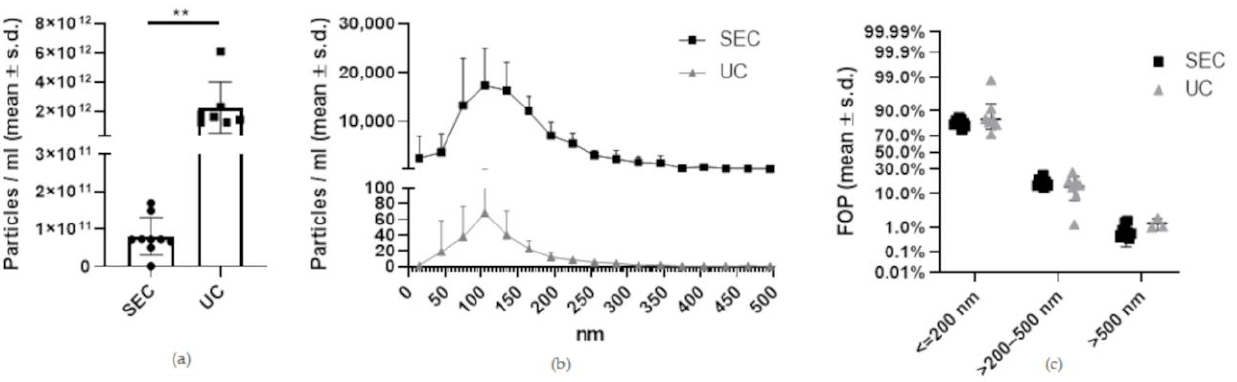
Figure 3. Particle number and size distribution of equine MSC-EVs based on NTA measurements. ( a ) Significantly more particles per ml were found in the UC isolates (** p = 0.0021). Black dots correspond to the SEC isolated samples and black squares to the UC isolated samples. ( b ) However, both methods resulted in a similar size distribution pattern, with most particles present below 200 nm. ( c ) Statistical analysis of the size distribution of particles identified by NTA analysis showed no significant differences of particles isolated using the UC or SEC.